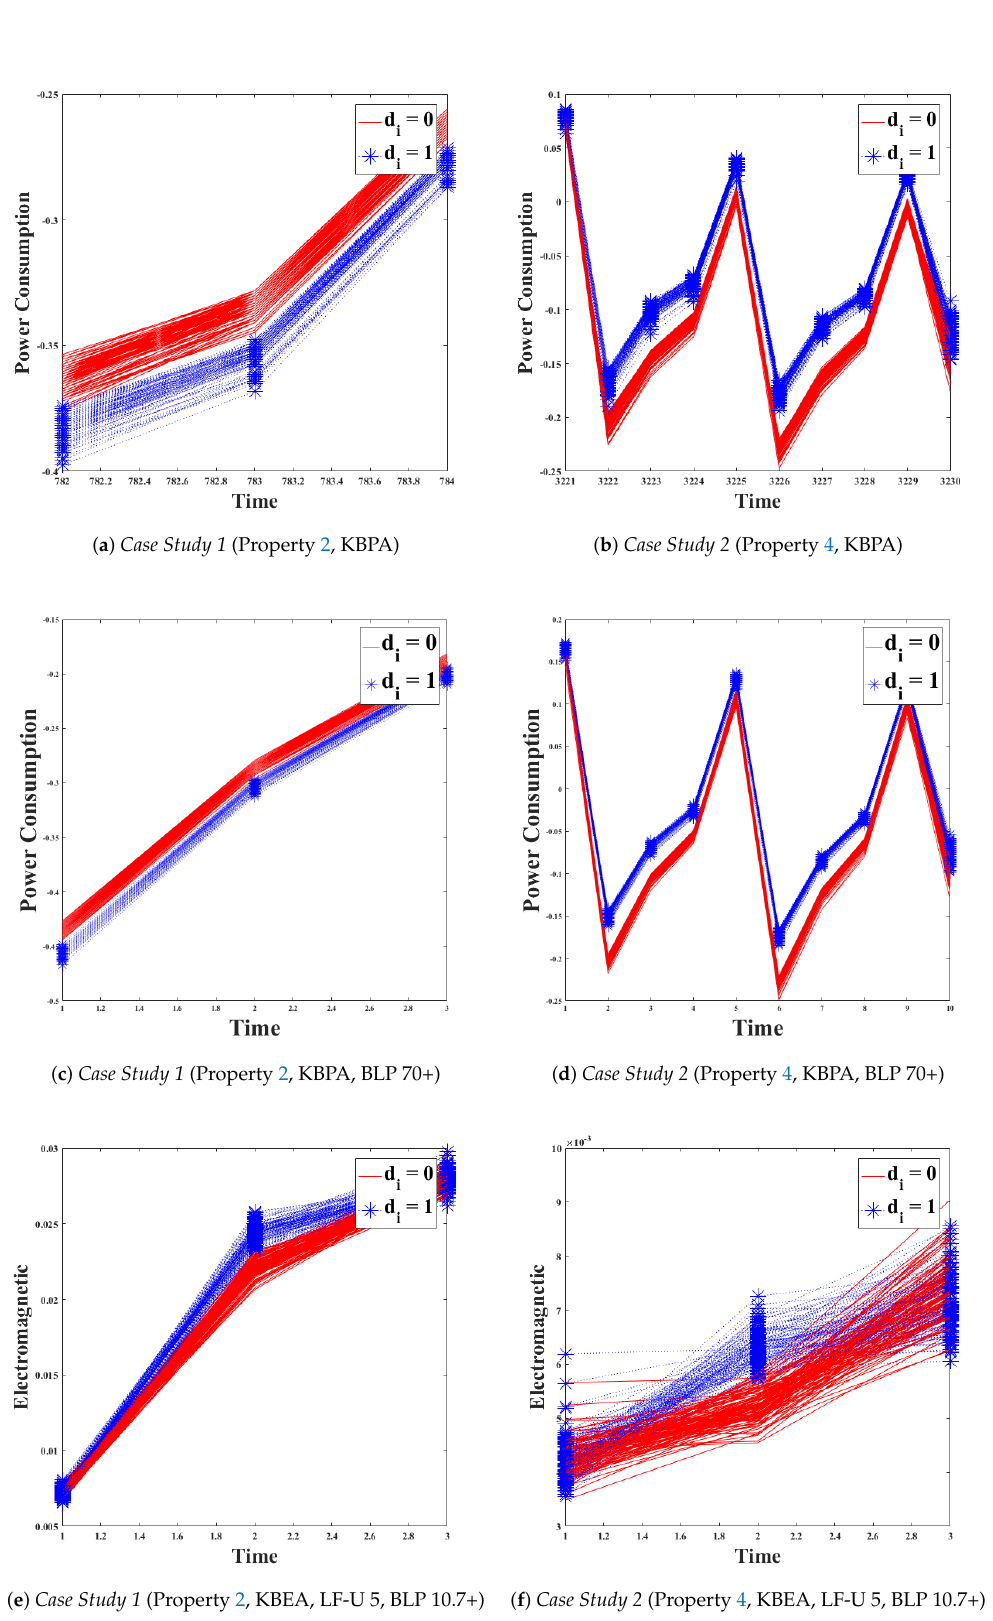
Figure 5. Classification result of PoIs (Software Implementation, mbedTLS). ( a ) Case Study 1 (Property 2, KBPA); ( b ) Case Study 2 (Property 4, KBPA); ( c ) Case Study 1 (Property 2, KBPA, BLP 70+); ( d ) Case Study 2 (Property 4, KBPA, BLP 70+); ( e ) Case Study 1 (Property 2, KBEA, LF-U 5, BLP 10.7+); ( f ) Case Study 2 (Property 4, KBEA, LF-U 5, BLP